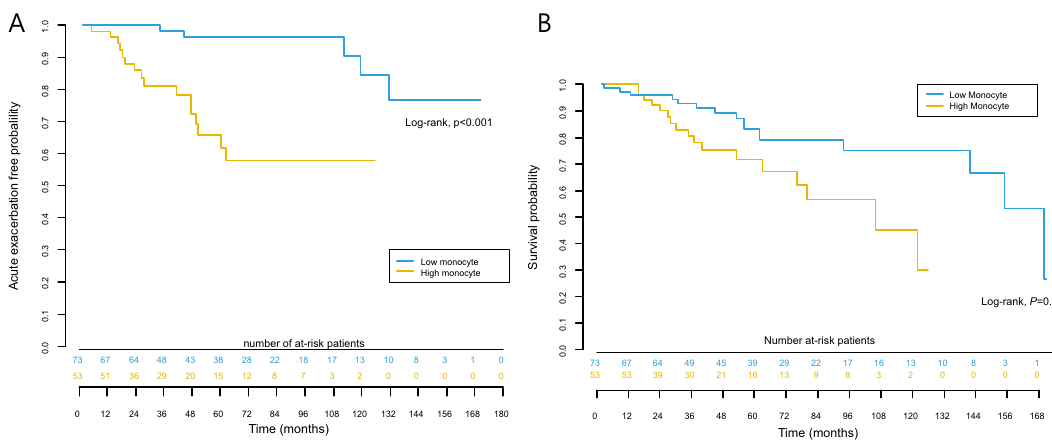
Time (months) Figure 2. ( A) Kaplan-Meier curves of time to first acute exacerbation for the patients with idiopathic nonspecific interstitial pneumonia according to monocyte counts. ( B) Kaplan–Meier survival curves of the patients with idiopathic nonspecific interstitial pneumonia according to monocyte